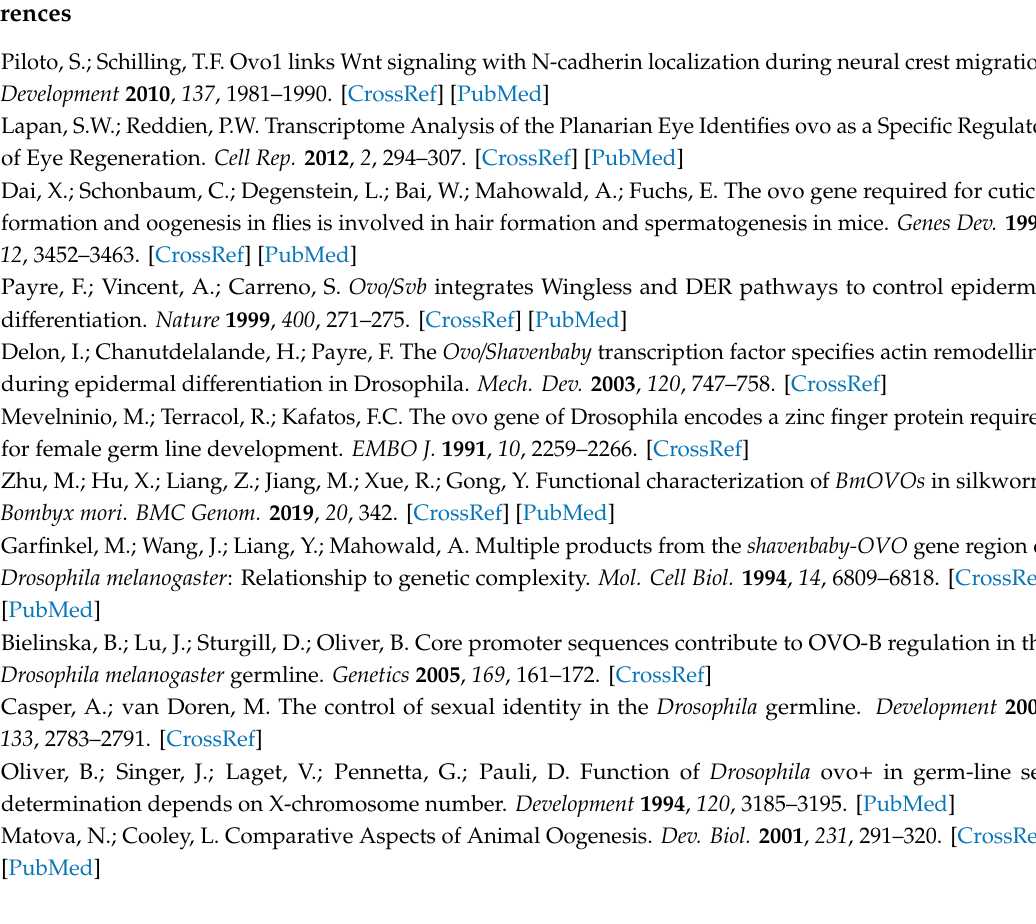
Figure S1: The expression of BmOvo-1 in head, fat body (FB), wing disc (WD), epidermis (Epi), middle silk gland (MSG), posterior silk gland (PSG), midgut (MG), and gonad at L5D3. RNA was extracted and reverse transcribed to cDNA and analyzed by real-time PCR. Three individual biological replicates of real-time PCR were performed., Figure S2: Transgenic plasmid construction and identification of BmOvo knock-out lines. (A) Schematic of the binary transgenic CRISPR / Cas9 system, which involves one line for expression of the full-length Cas9 ORF driven by the nos promoter and another line for U6 promoter-driven expression of two sgRNAs. These two lines also contain the reporter genes EGFP and DsRed, respectively, under the control of the IE1 promoter. (B) Parental transgenic strains expressing Cas9 or sgRNA were established. Somatic mutations were induced in the F1 founder animals following crosses of these two strains. Red and green fluorescence in the entire body confirmed the presence of the appropriate transgene constructs. Scale bars, 1 mm., Figure S3: The BmOvo mutants showed abnormal wing discs, disorder eggs in the ovarioles, small testes and ovaries. (a) Wild-type and (a (cid:48) ) mutant wing disc at L5D3-stage. The black arrows indicate the atrophic and malformed region of wing disc in BmOvo mutant. (b) Wild-type and (b (cid:48) ) mutant testes at L5D3 stage. (c) Wild-type and (c (cid:48) ) mutant ovaries at L5D3 stage. (d) Wild-type and (d (cid:48) ) mutant ovarioles in adults. Scale bars, 0.5